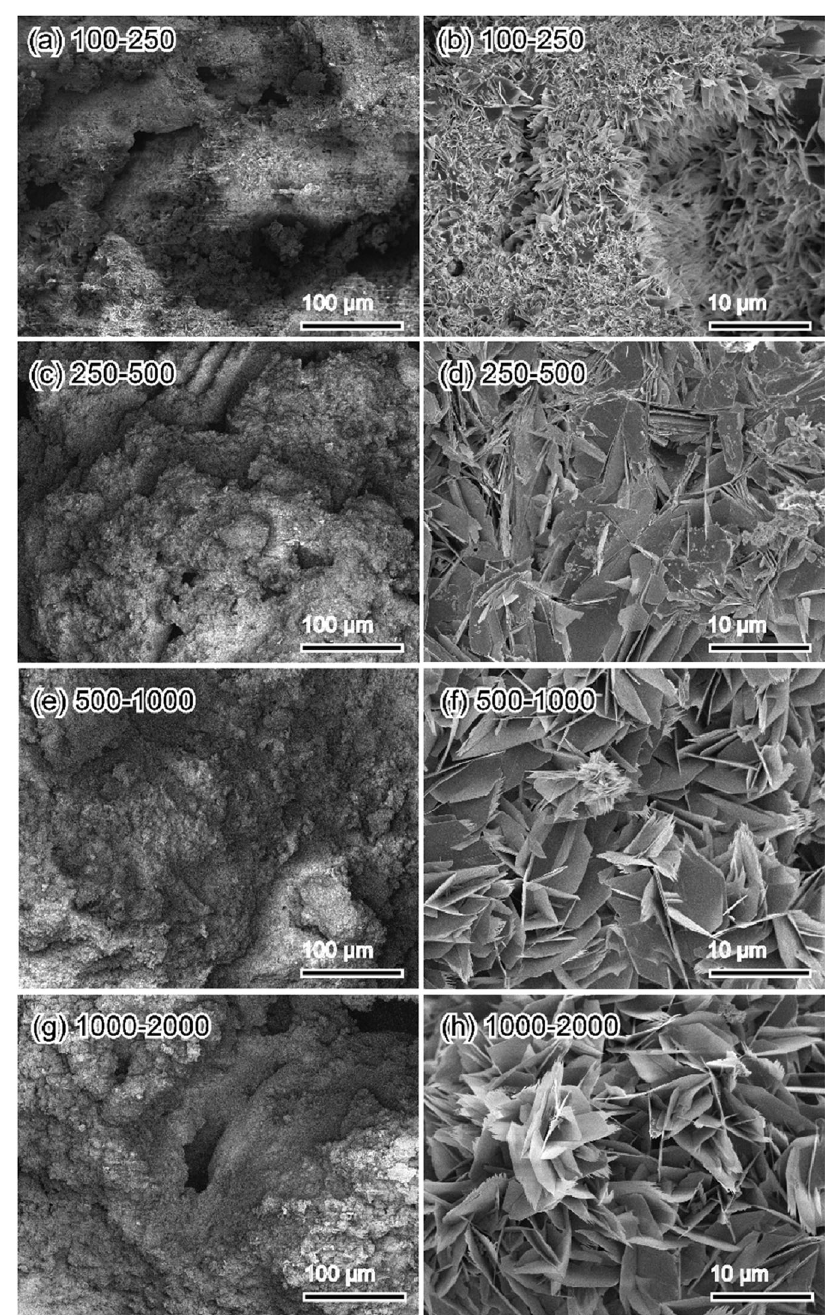
Fig. 5 Representative